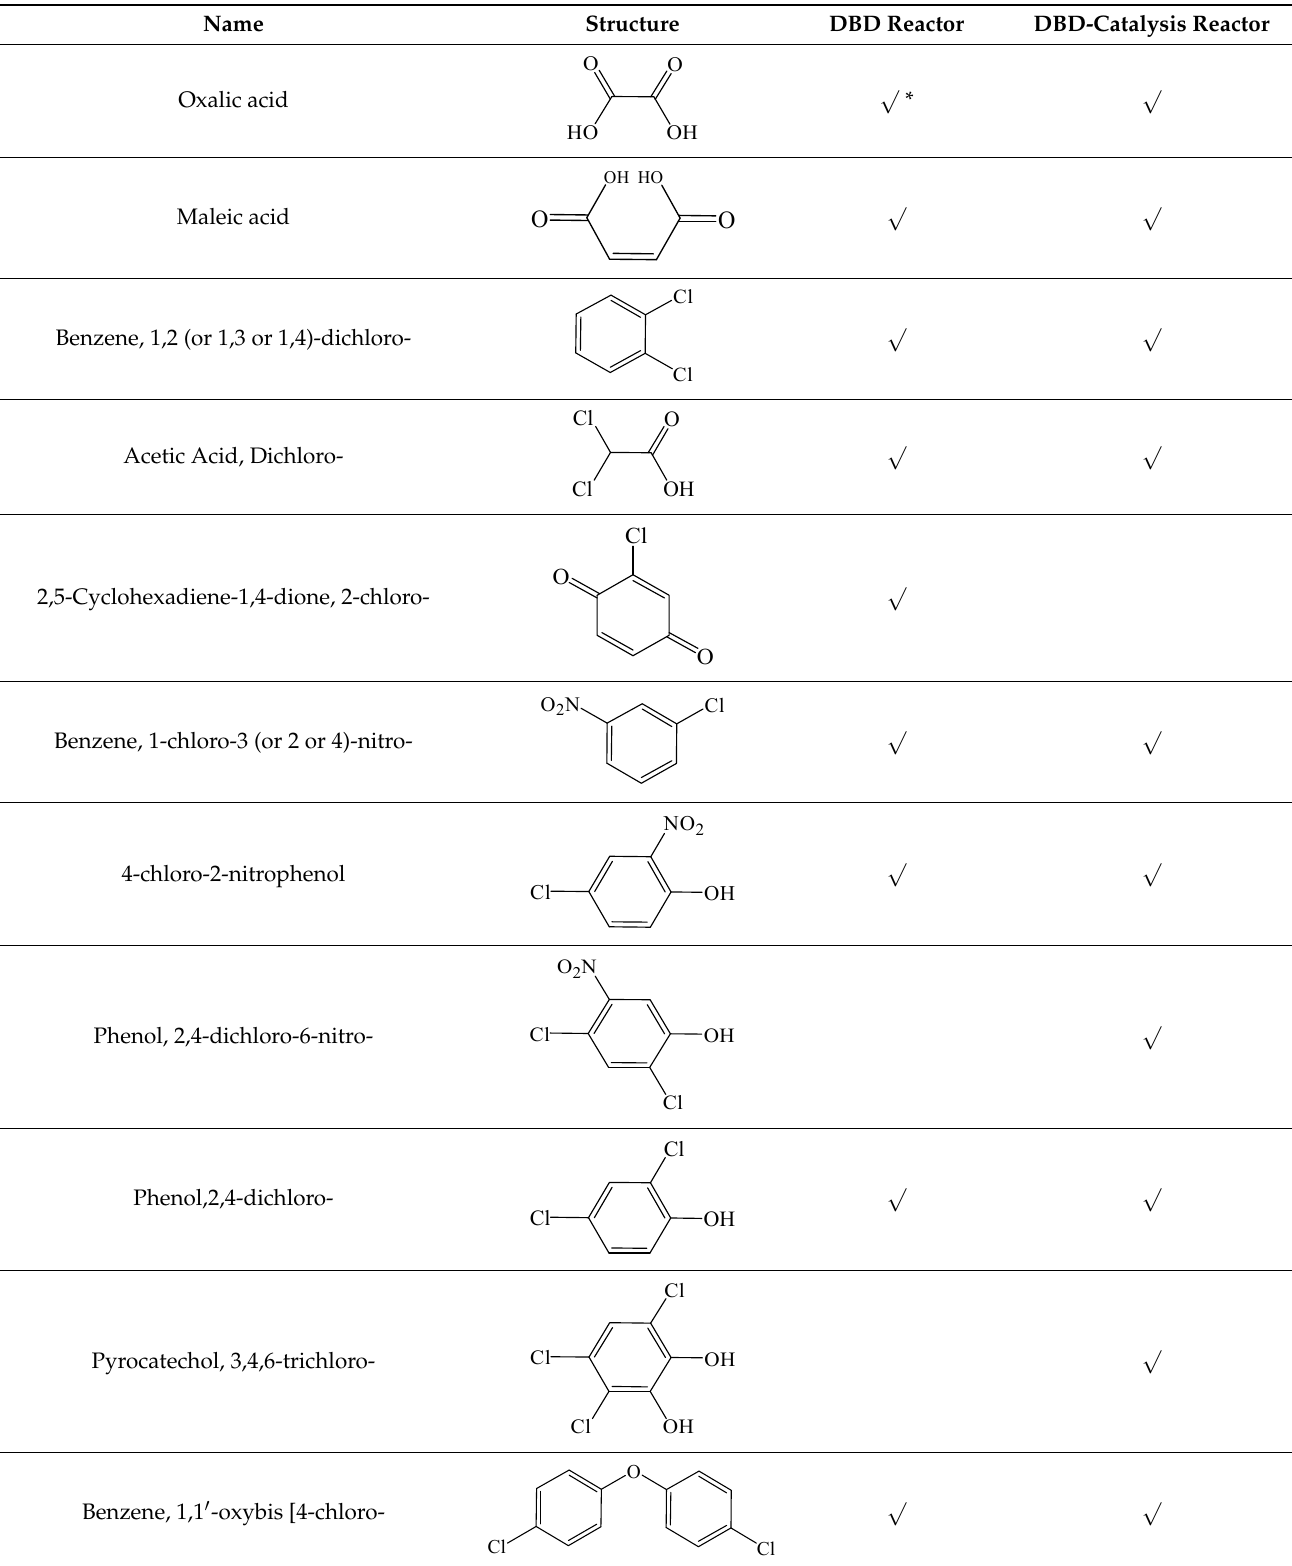
Table 4. Byproducts analysis Table 4. Byproducts analysis results. Table 4. Byproducts analysis results. Table 4. Byproducts analysis results. Table 4. Byproducts analysis results. Table 4. Byproducts analysis results. Table 4. Byproducts analysis results. Table 4. Byproducts analysis results. Table 4. Byproducts analysis results. Table 4. Byproducts analysis results. Table 4. Byproducts analysis results. Table 4. Byproducts analysis results.